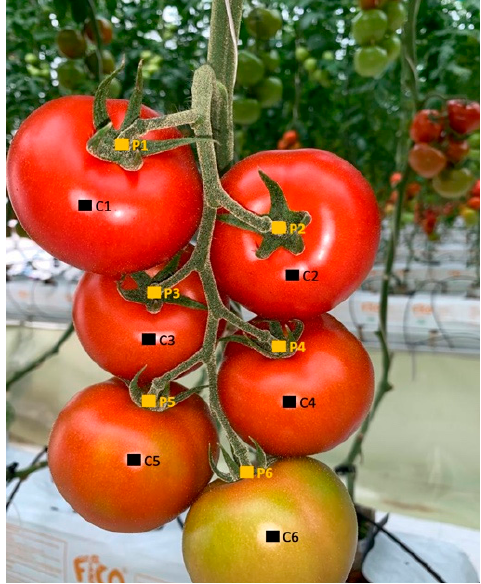
Figure 18. Convex area center (C) and peduncle (P) tomato detection.